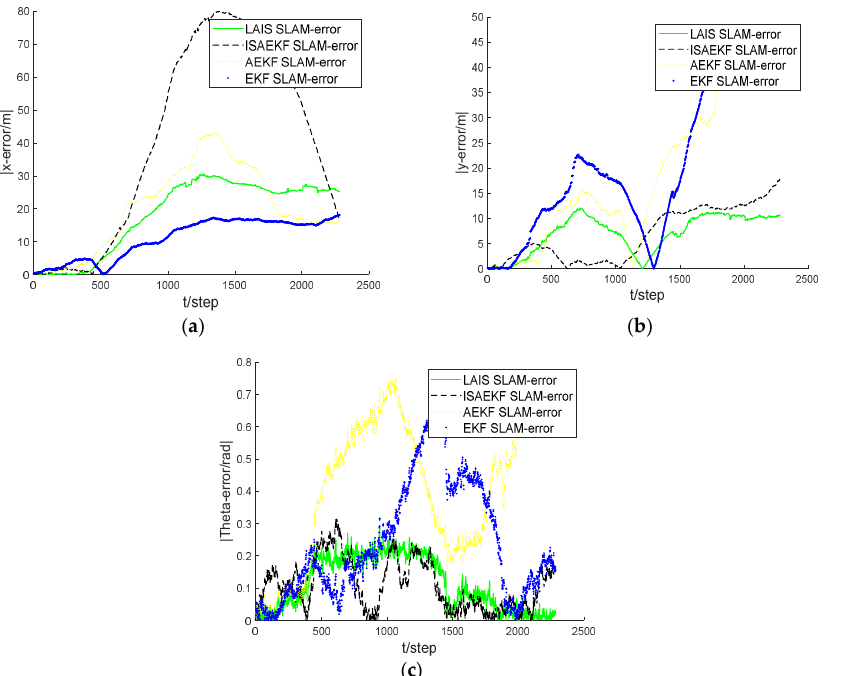
Figure 4. Error of each algorithm when the signpost point is 80 under achromatic noise. ( a ) x axis direction error . ( b ) y axis direction error. ( c ) Rotation angle error.